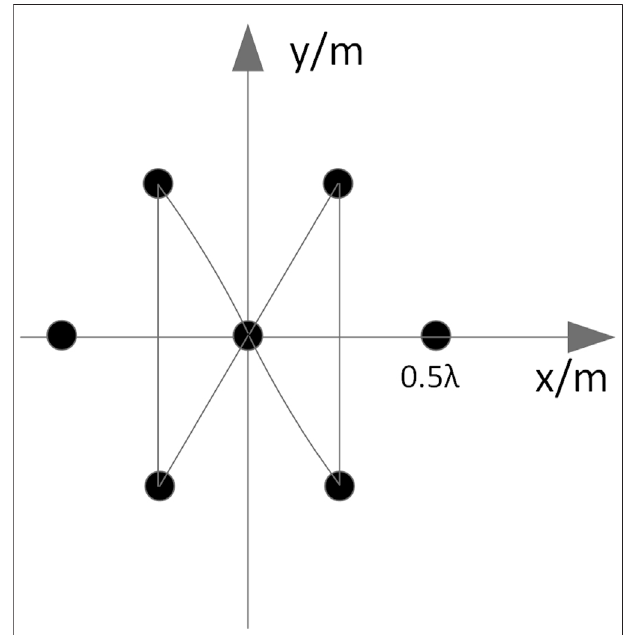
FIGURE 2 | Schematic diagram of the arrangement of antenna array